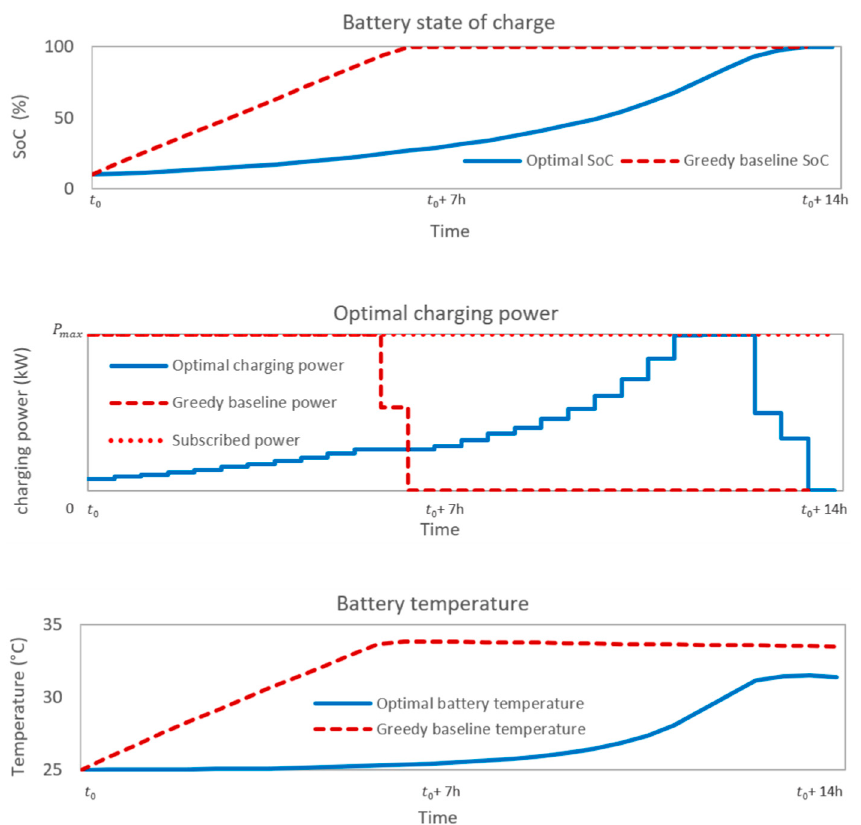
Figure 7. Optimal charging schedules scenario 1 and greedy baseline strategy.